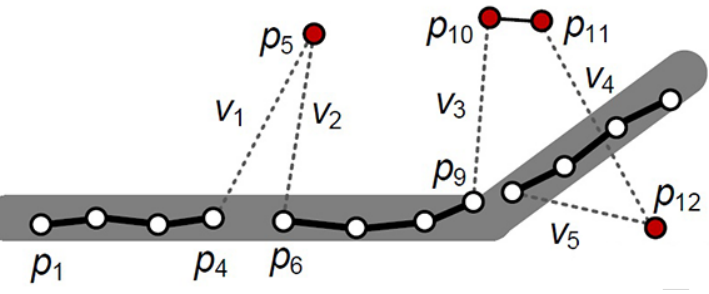
Figure 2. Outlier point removal algorithm.